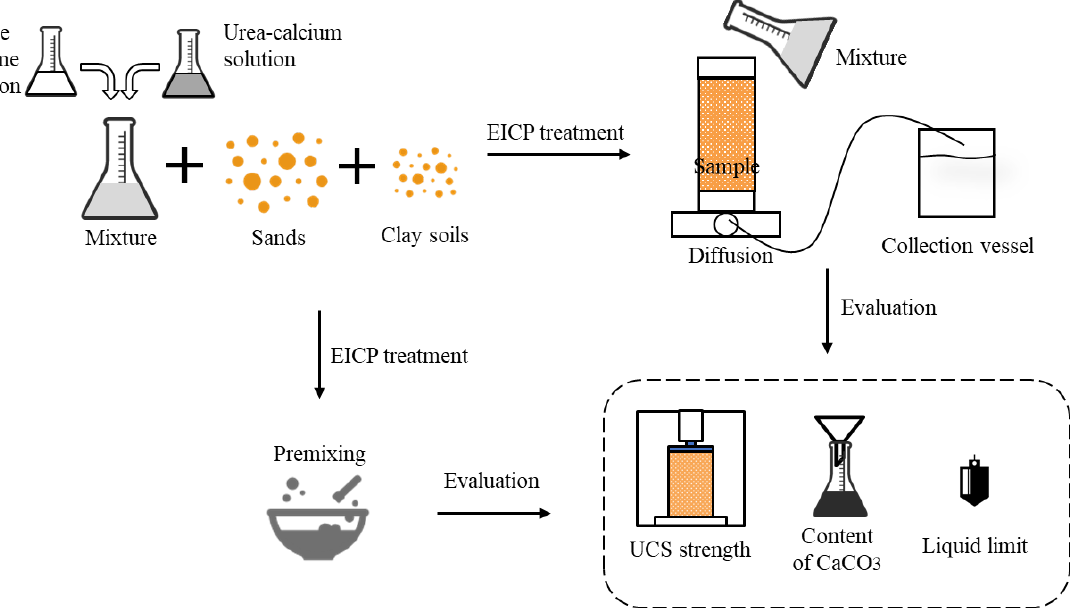
Figure 1. Schematic set-up of experiments.